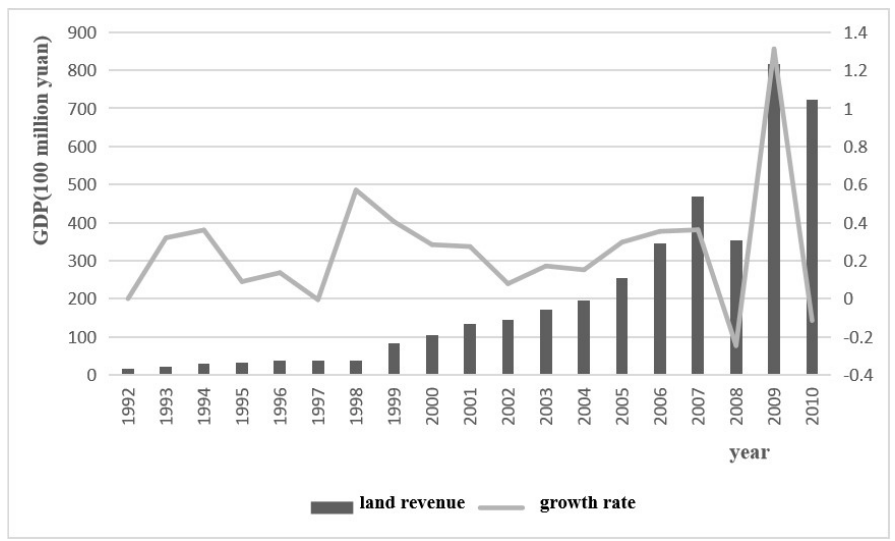
Figure 4. Financial revenue and growth rate of land in Guangzhou. Sources: Guangzhou Statistical Yearbook.